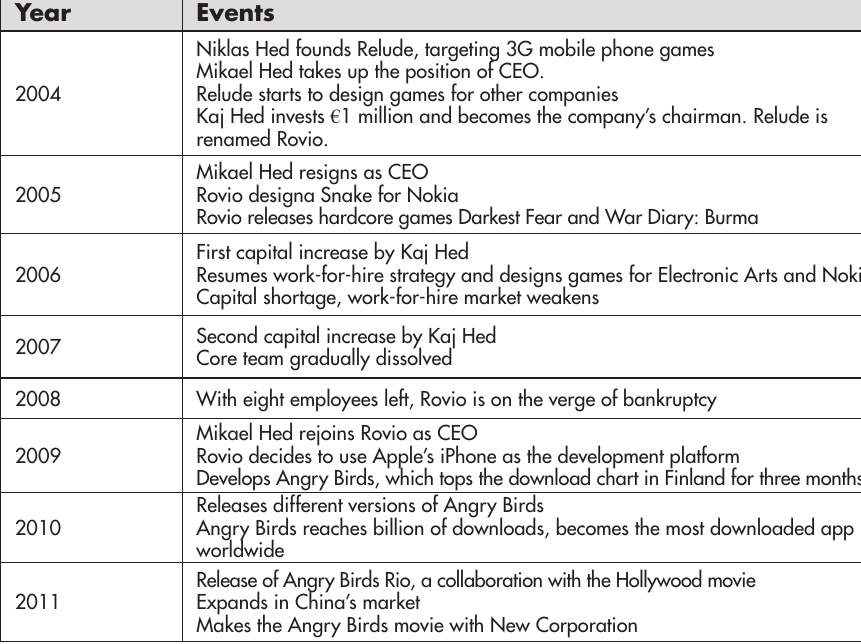
Table 2 Timeline of Rovio and Angry